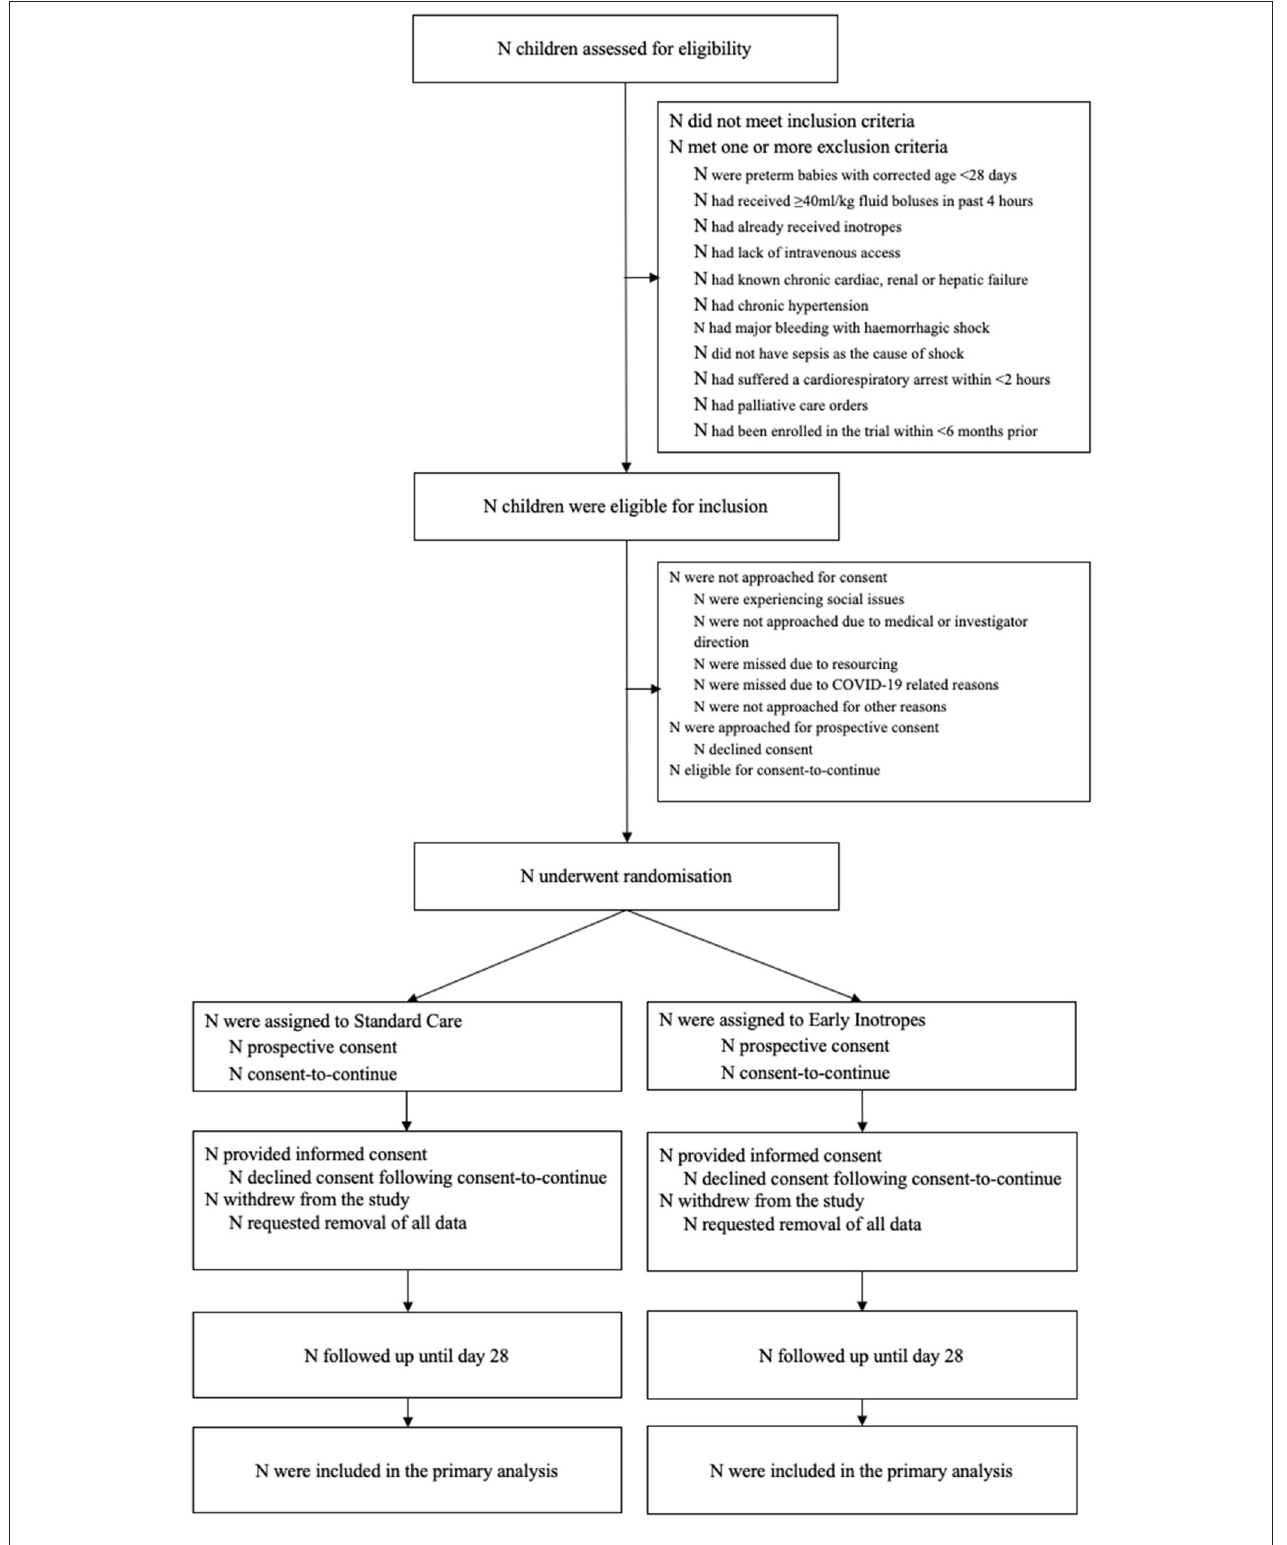
FIGURE 1 | CONSORT participant flow diagram for RESPOND